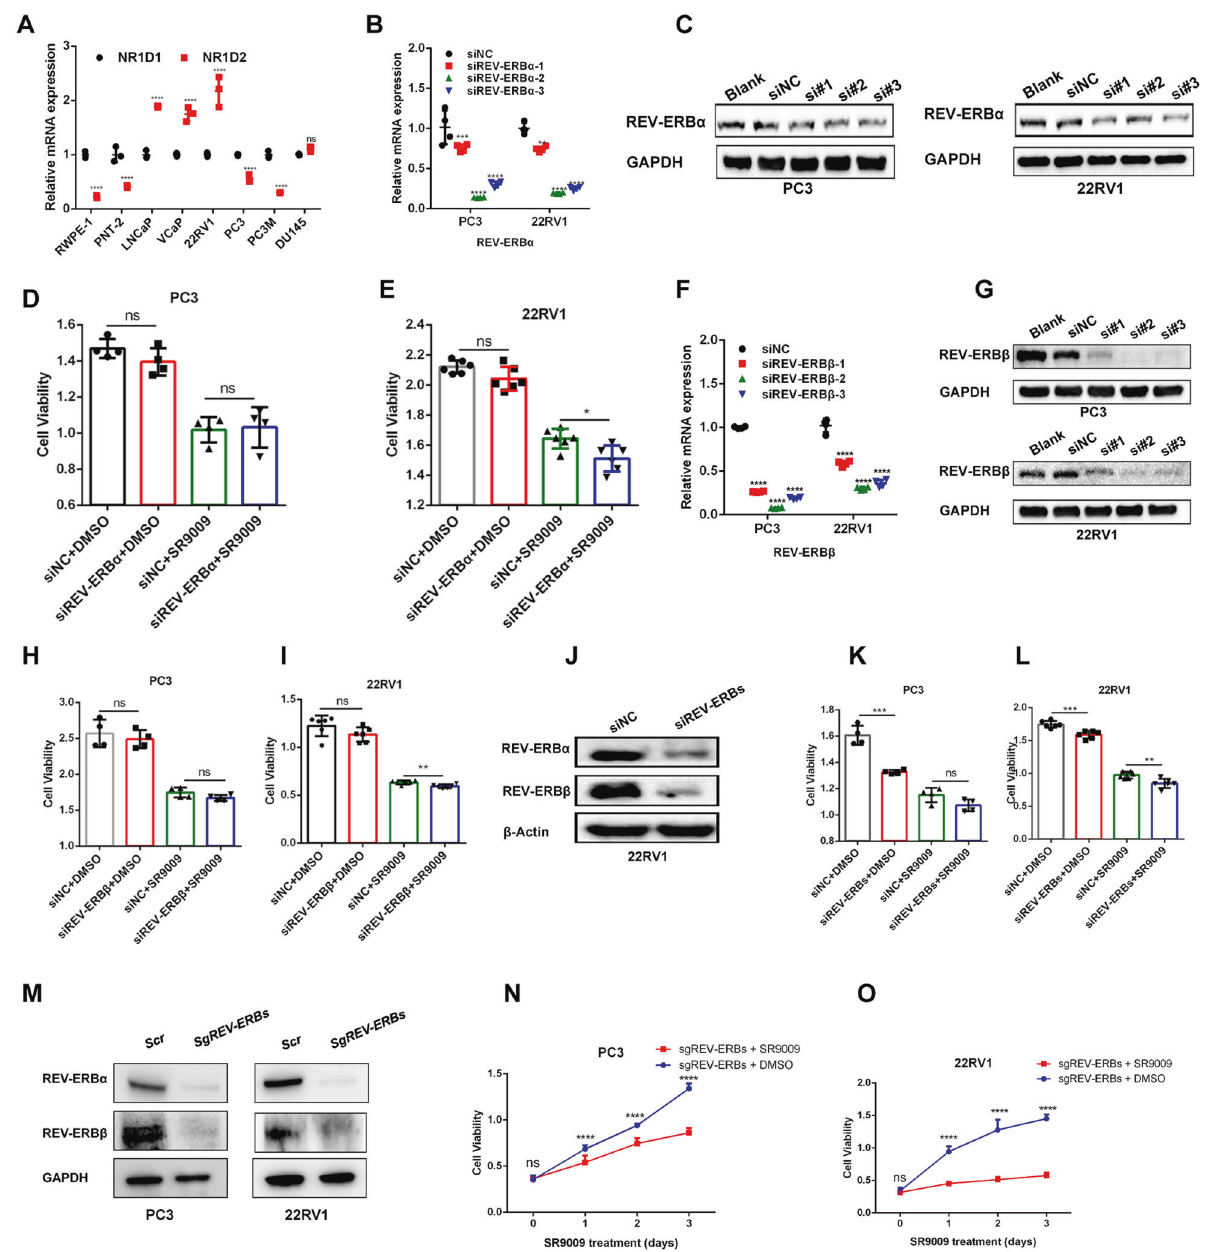
Fig. 5 SR9009-induced FOXM1 pathway inhibition was independent of REV-ERBs. A Relative mRNA expression levels of REV-ERB α and REV- ERB β across eight prostate cell lines; n = 3; means ± SDs; ANOVA. B qPCR of REV-ERB α knockdown validation in PC3 and 22RV1 cells using 3 siRNAs; n = 4; means ± SDs; ANOVA. C Western blot validation of REV-ERB α knockdown in PC3 and 22RV1 cells using 3 siRNAs. D , E CCK-8 assay showed that knockdown of REV-ERB α could not rescue SR9009-induced cytotoxicity in PC3 ( D ; n = 4; means ± SDs; unpaired t test) and 22RV1 ( E ; n = 6; means ± SDs; unpaired t test) cells. F , G qPCR ( F ; n = 4; means ± SDs; ANOVA) and Western blot ( G ) of REV-ERB β knockdown validation in PC3 and 22RV1 cells using 3 siRNAs. H , I CCK-8 assay showed that knockdown of REV-ERB β could not rescue SR9009-induced cytotoxicity in PC3 ( H ; n = 4; means ± SDs; unpaired t test) and 22RV1 ( I ; n = 6; means ± SDs; unpaired t test) cells. J Western blot of REV-ERB knockdown validation in 22RV1 cells. K , L CCK-8 assay showed that knockdown of REV-ERBs could not rescue SR9009-induced cytotoxicity in PC3 ( K ; n = 4; means ± SDs; unpaired t test) and 22RV1 ( L ; n = 6; means ± SDs; unpaired t test) cells. M Western blot validation of REV-ERB protein levels through CRISPR/Cas9 gene editing in PC3 and 22RV1 cells. N-O: PC3 ( N , n = 8 means ± SDs; ANOVA) and 22RV1 ( O , n = 8 means ± SDs; ANOVA)-REV-ERB knockout cells were treated with SR9009 (20 μ M) or DMSO for 3 days. ns, not signi fi cant; * p < 0.05; ** p < 0.01; *** p < 0.001; **** p < 0.0001. showed that the high expression levels of these 7 genes were all BIRC5, after intersection between PCS1 genes and FOXM1 pathway- associated with adverse clinicopathological outcomes in PCa (Fig. involved genes (Fig. 4A). The expression of these 7 genes was S3A-D). We show the expression heatmap of these 7 genes strati fi ed signi fi cantly downregulated after SR9009 treatment (Fig. 4B). Previous by Gleason score in Fig. 4C (with the Gleason score increased, the studies have validated the important role of these 7 genes in expression of these 7 genes was elevated). Moreover, the high promoting PCa progression [21 – 25]. Our bioinformatic analyses